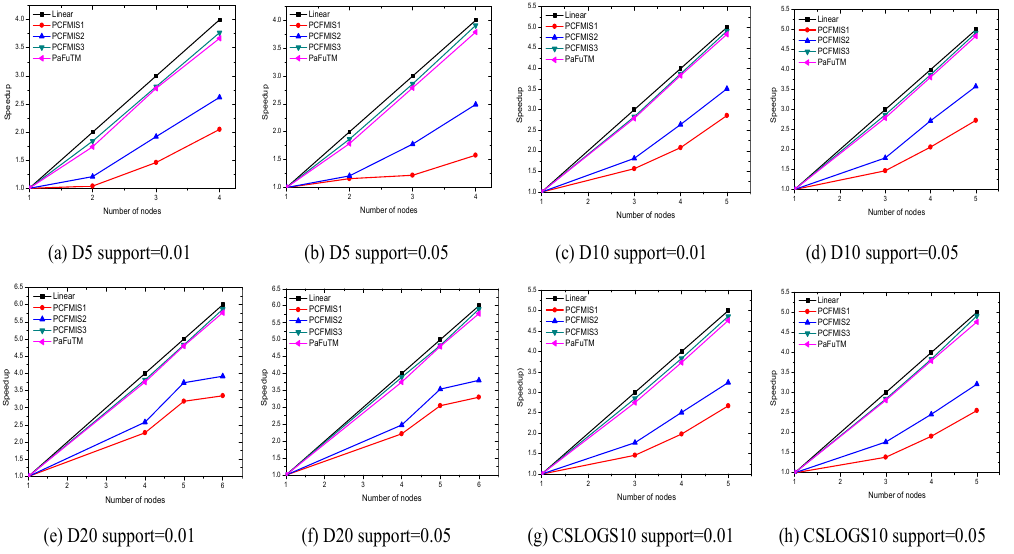
Figure 7. The speedups of four algorithms for four data sets on a small number of